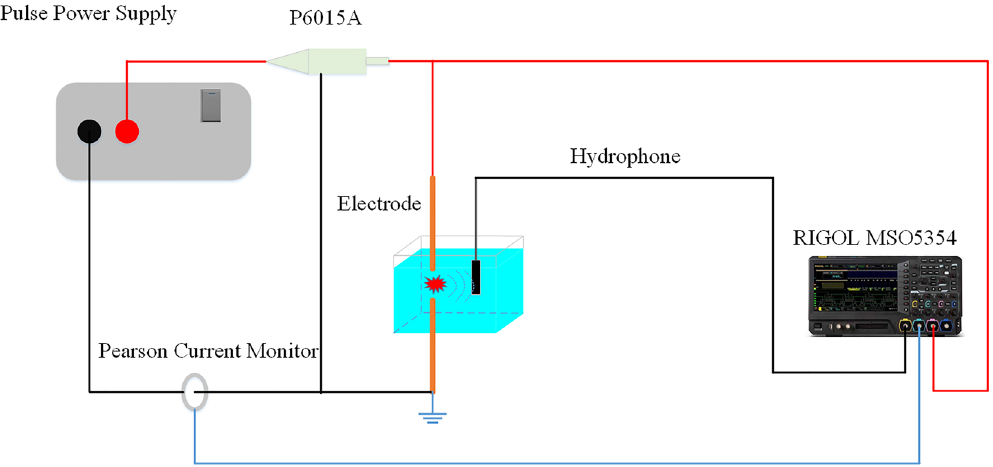
Figure 1. Experimental apparatus of the underwater discharge